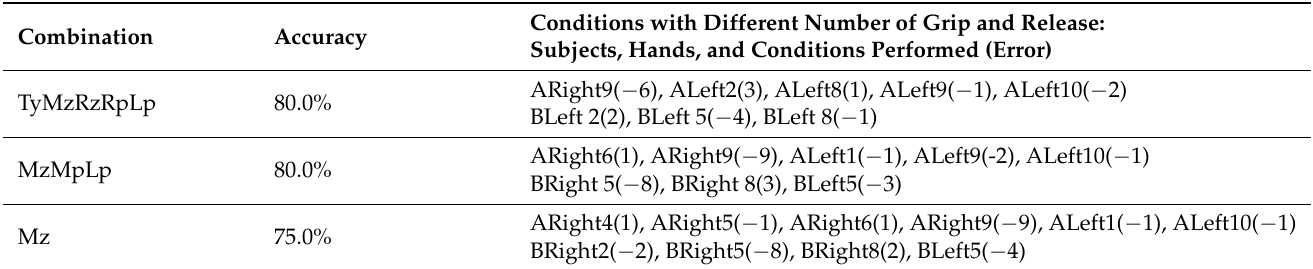
Table 4. Combination and number of grip and